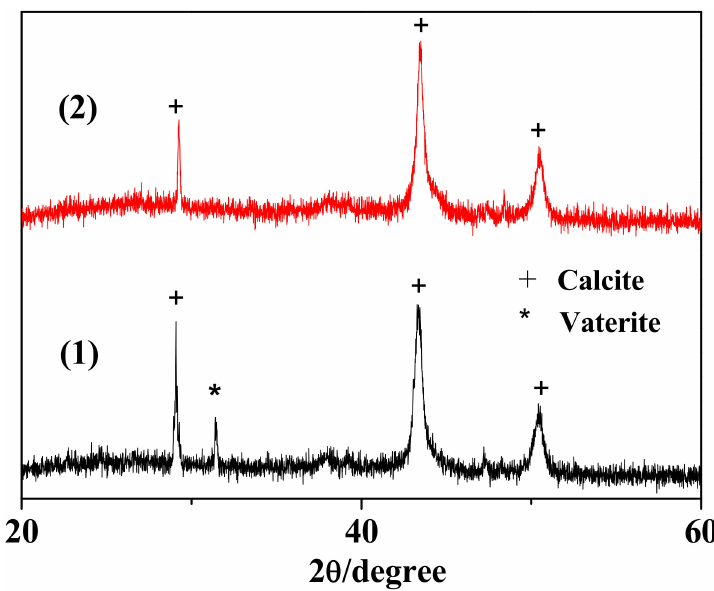
Figure 8. XRD pattern of CaCO 3 crystals formed on the cathode surface under polarization at − 1.5 V: ( 1 ) blank; ( 2 ) containing 8 mg / L